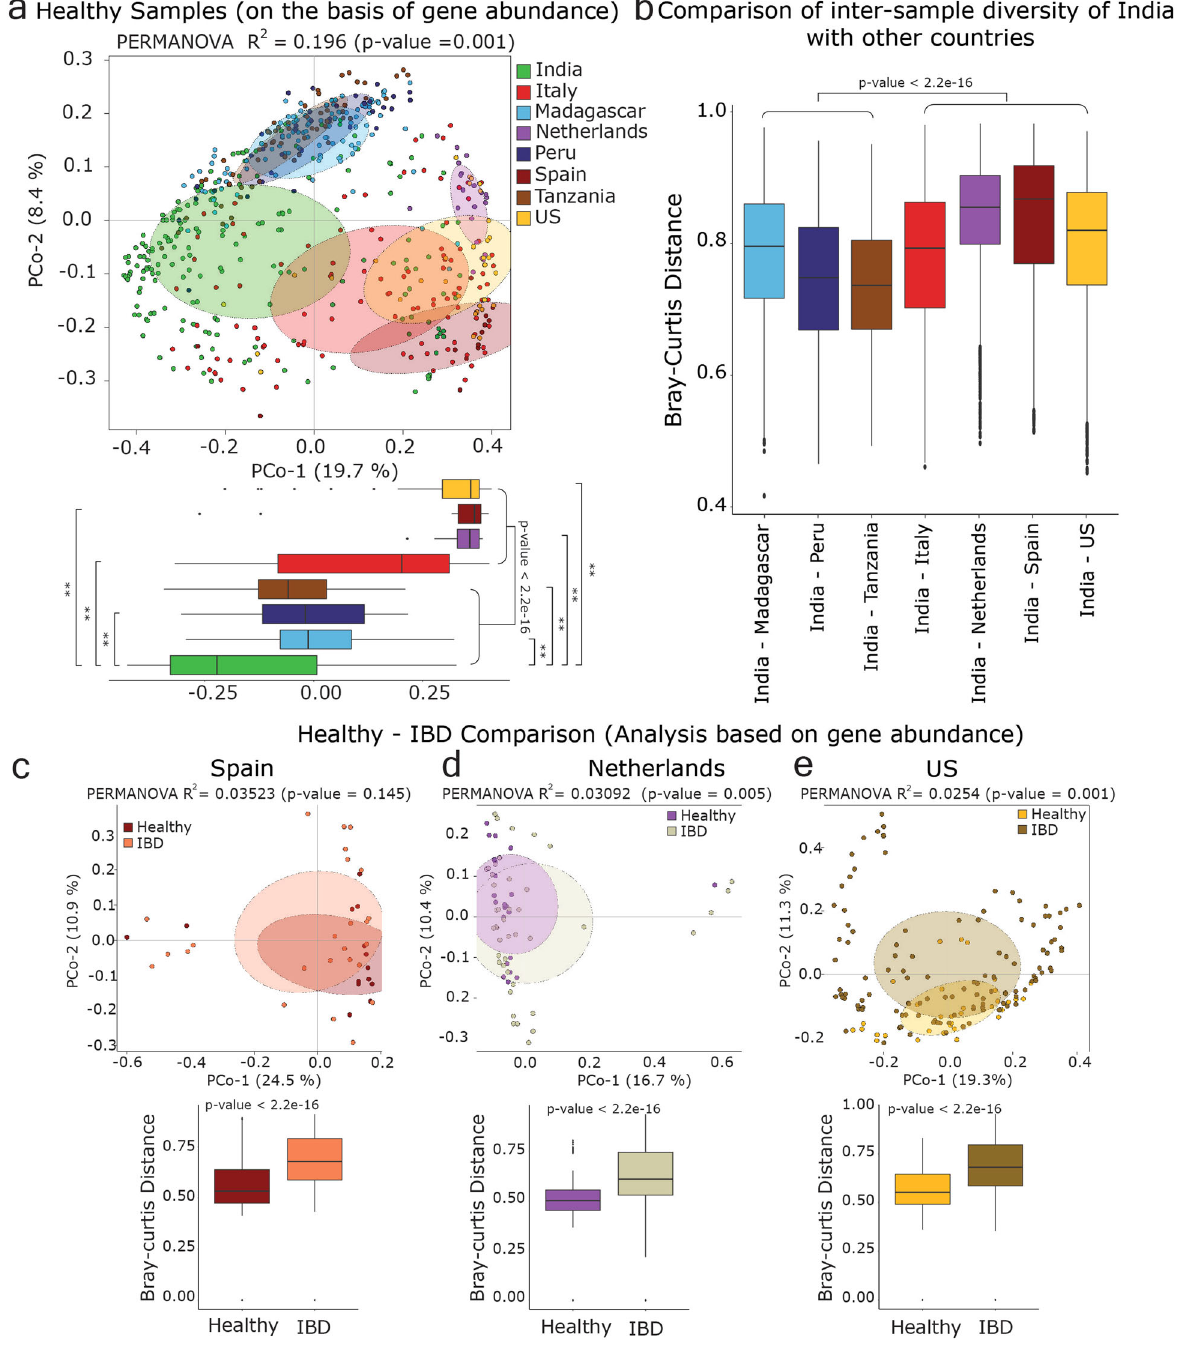
Fig. 5 Functional composition of Prevotella genus in healthy and IBD cohorts. a Principal coordinates analysis considering inter-sample Bray – Curtis distance based on the relative abundance of genes from PGC ( Prevotella Gene Catalog) in healthy populations. The fi gure shows western and non-western populations are signi fi cantly separated based on the fi rst principal coordinate. The fi gure also shows that the Indian population has a signi fi cantly distinct Prevotella gene composition. b Box plot showing the inter-sample distance (Bray – Curtis) of Indian samples with other populations based on the relative abundance of genes of PGC. c – e Principal coordinates analysis considering inter-sample Bray – Curtis distance based on the relative abundance of genes of PGC in western-healthy and IBD samples (Spain, Netherlands and US, respectively). Box plots of inter-sample distance in healthy and IBD samples are shown at the bottom part of each PCoA plot. The whiskers, bound of the box, and the line in the middle of the box represent the min-to-max values, 25th – 75th percentiles, and median, respectively. Nonparametric two-sided Wilcoxon rank-sum test was used to test the box-plot